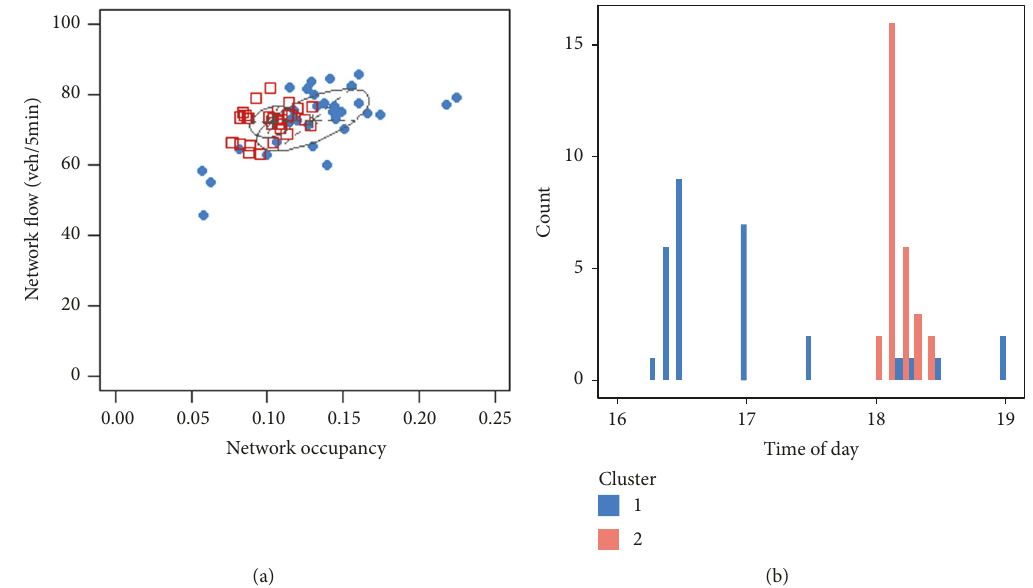
Figure 8: Day-to-day pattern of the CTS points from the afternoon peaks of 38 weekdays. (a) Flow-occupancy distribution in two clusters. (b) Time distribution in two